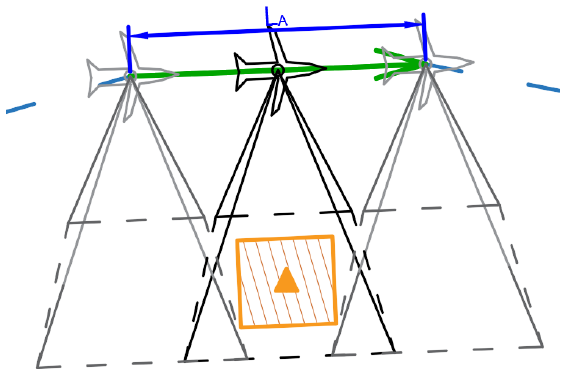
Figure 3. Figure representing geometrical relations between flight segment and scanned POI.